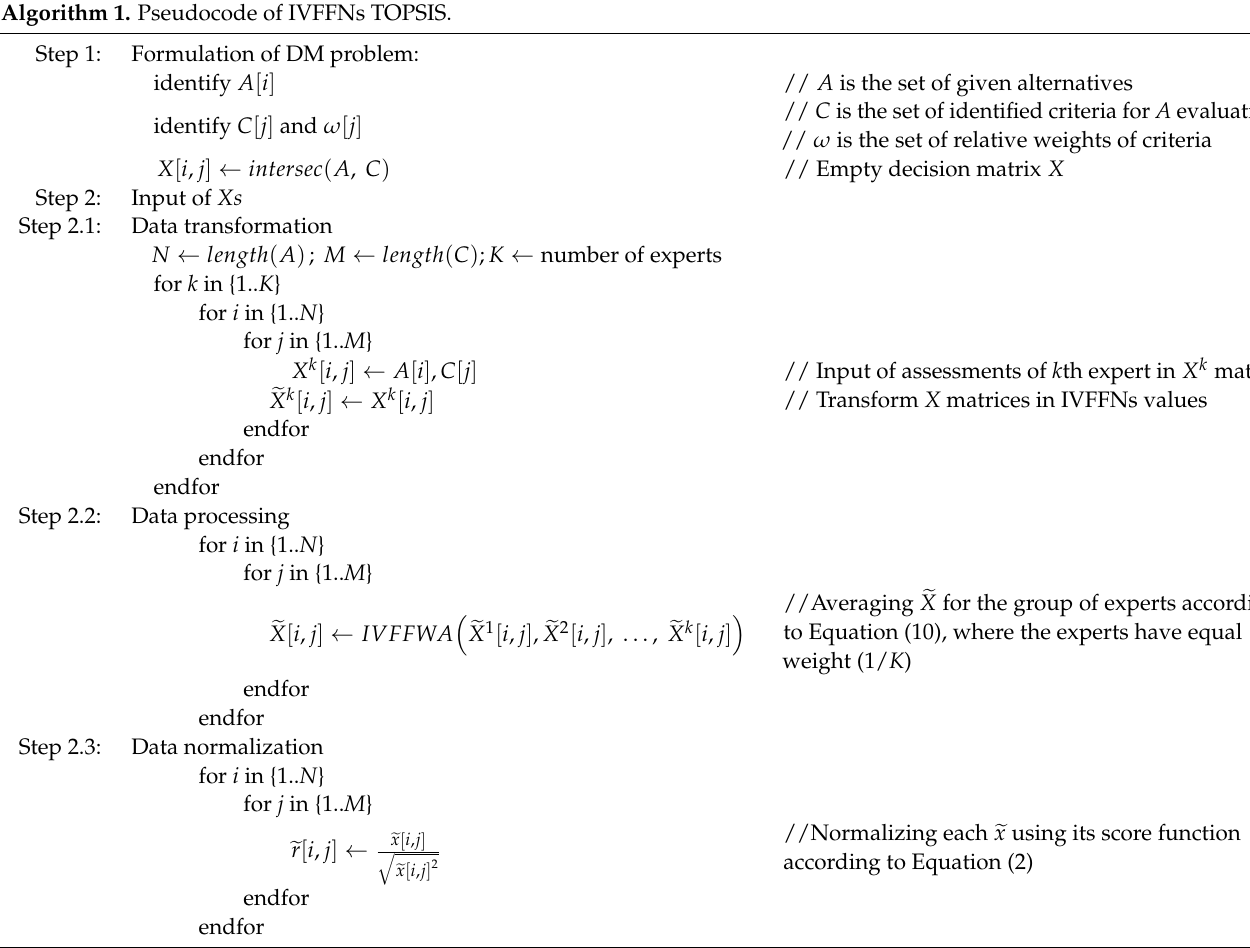
Algorithm 1. Pseudocode of IVFFNs